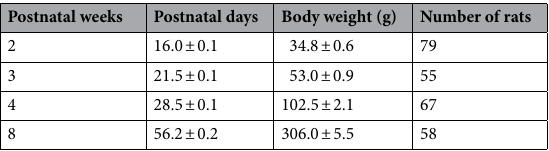
Table 1. Postnatal groups and body weight. Data are the means ±